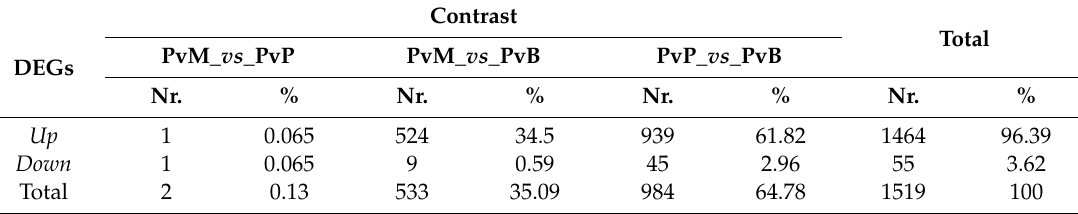
Table 1. Number (Nr.) and percentage (%) of di ff erentially expressed genes (DEGs) by Plasmopara viticola (Pv) when inoculated on Mgaloblishvili (M) in comparison with Pinot noir (P) (PvM_ vs _PvP), Mgaloblishvili in comparison with Bianca (B) (PvM_ vs _PvB), and Pinot noir in comparison with Bianca (PvP_ vs